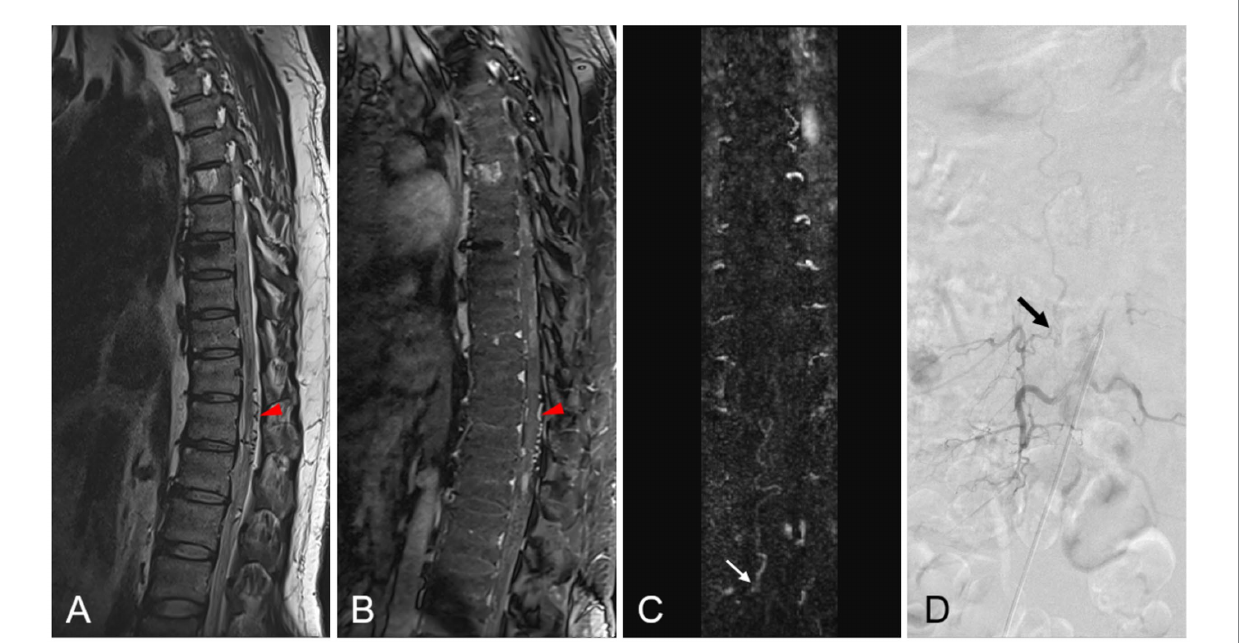
FIGURE 1 A 42-year-old patient with spinal dural arteriovenous fistula (SDAVF) at the L2-3 level on the right side. (A,B) Sagittal T2-weighted image and enhanced T1-weighted image shows prominent perimedullary vein ( red arrowhead ). (C) The coronal MRA MIP image demonstrates the feeding artery of the SDAVF at the L2-3 level on the right side ( white arrow ). (D) The localization of this origin is confirmed by DSA ( black arrow ).